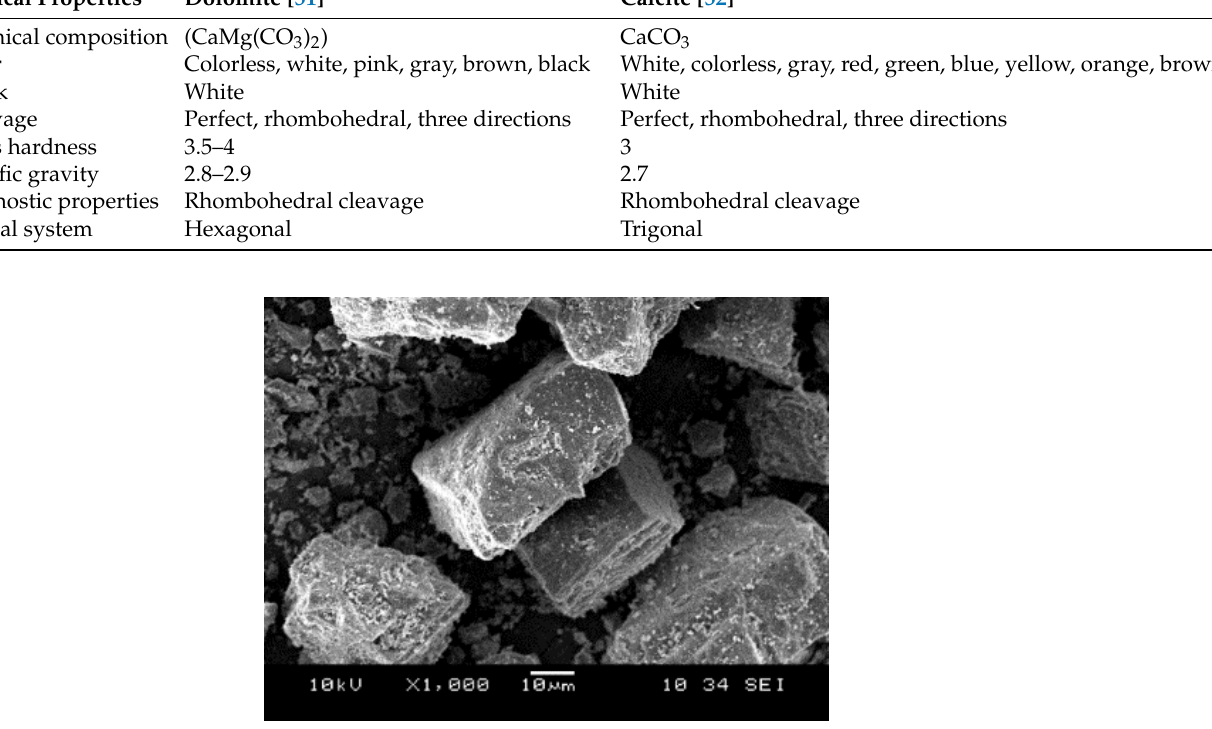
Figure 6. SEM image of raw dolomite particles.